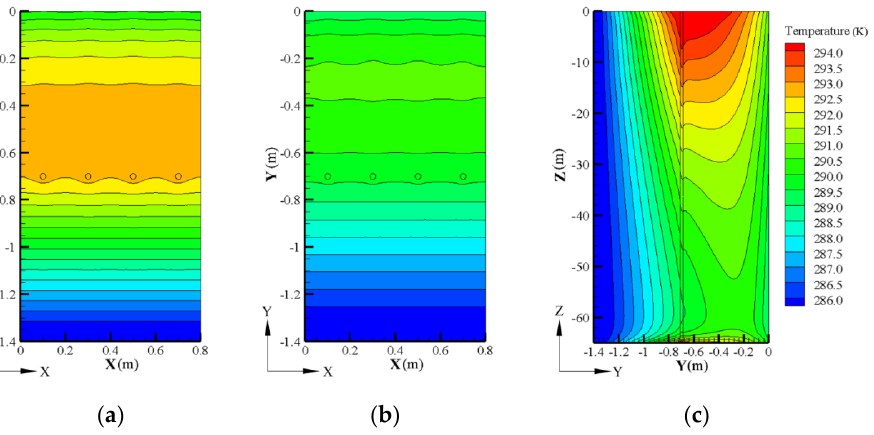
Figure 23. Soil temperature at 4:00 on 6 January 2020. ( a ) Z = − 15 m, ( b ) Z = − 50 m, and ( c ) X = 0.3 m (the X-to-Y ratio is set as 20).